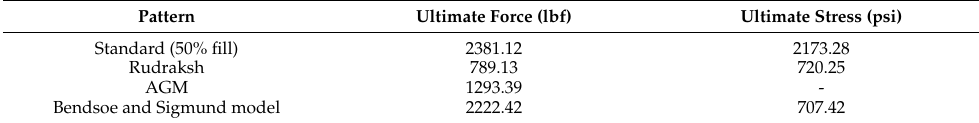
Table 2. Generic comparison of a few cases for mechanical strength.